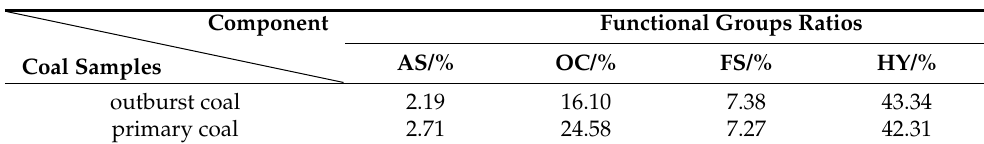
Figure 2. Fourier infrared spectra of coal samples. Table 2. Ratios of various functional groups.